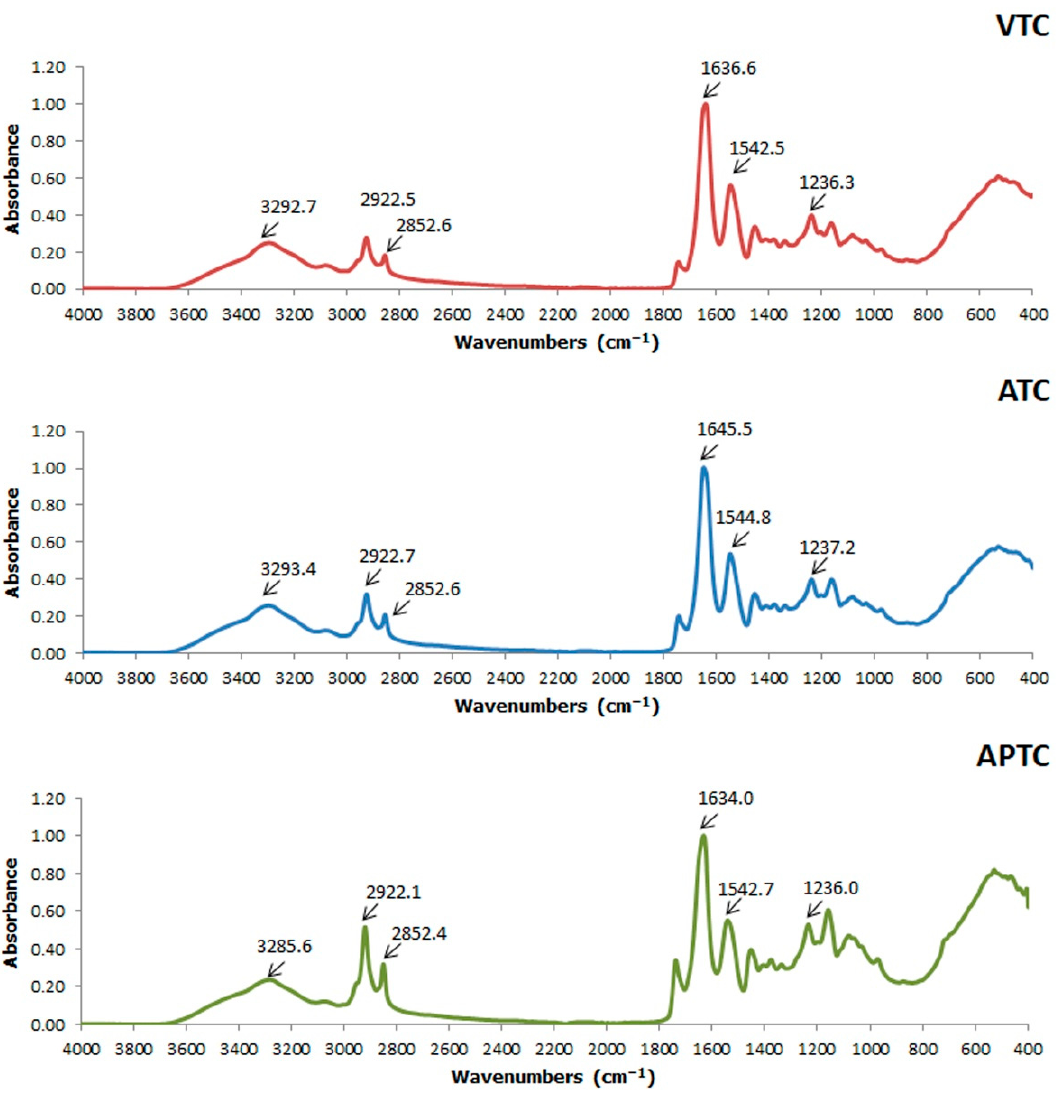
Figure 3. The FTIR spectra wavenumber of tuna-tail-tendon collagens (VTC: acid-solubilized collagen using vinegar extraction, ATC: acid-solubilized collagen using acetic-acid extraction, and APTC: pepsin-solubilized collagen).